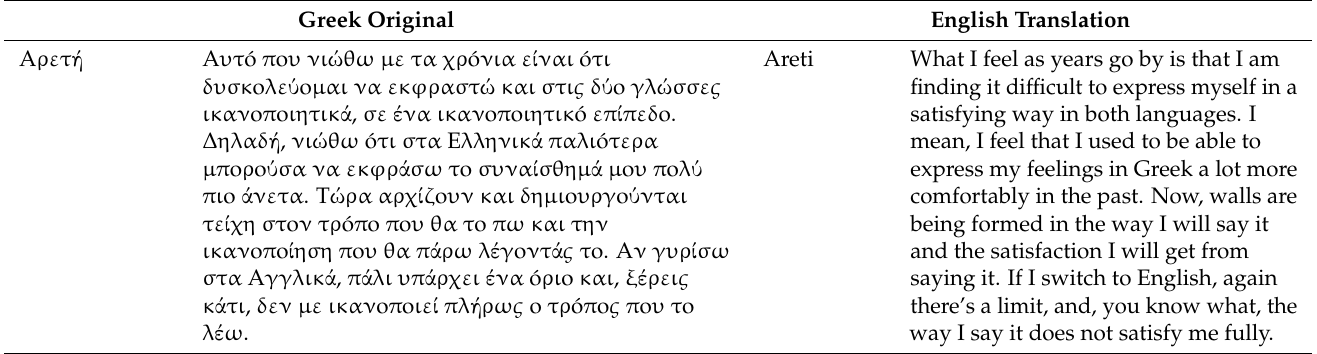
Table 9. “Walls are being